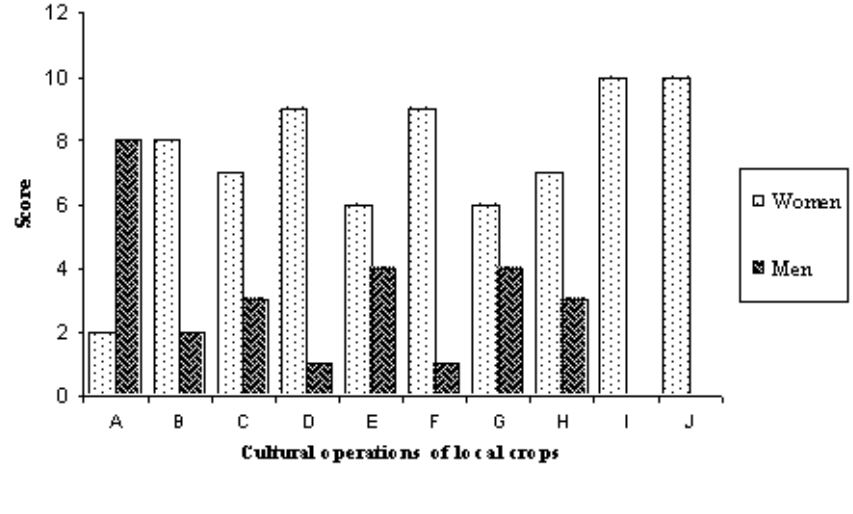
A=land preparation, B=seed selection, C=seed sowing, D=weeding, E=irrigation, F=harvesting,